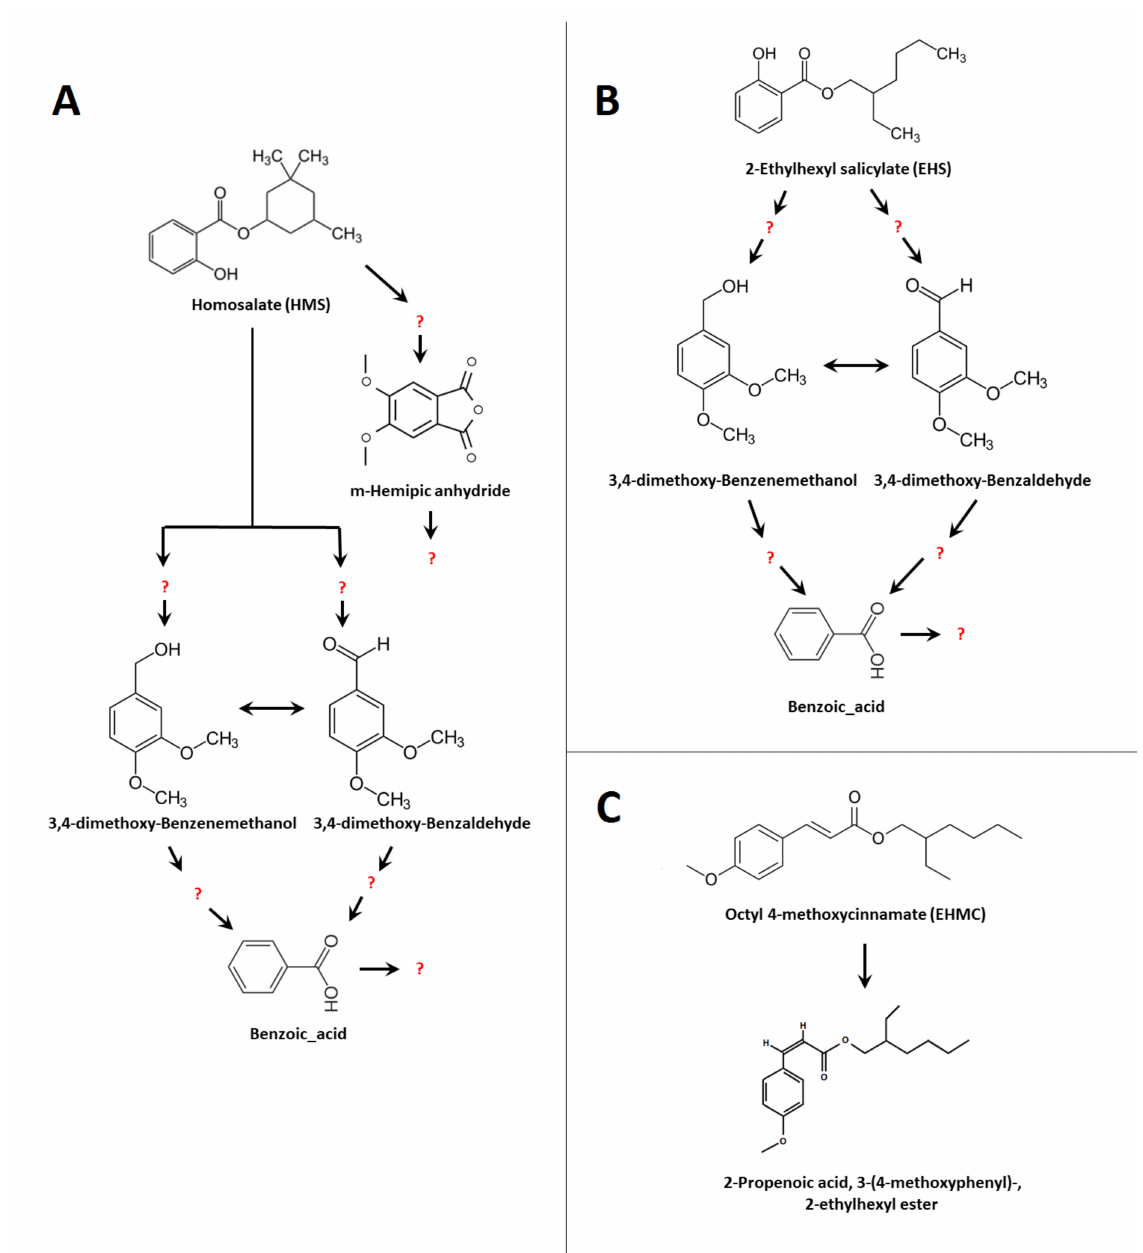
Figure 5. Intermediates of the biodegradation and biotransformation of homosalate ( A ), 2-ethylhexyl salicylate ( B ) and ethylhexyl methoxycinnamate ( C ) by enzyme extracts from the spent mushroom compost of Pleurotus djamor . Question marks indicate unidentified